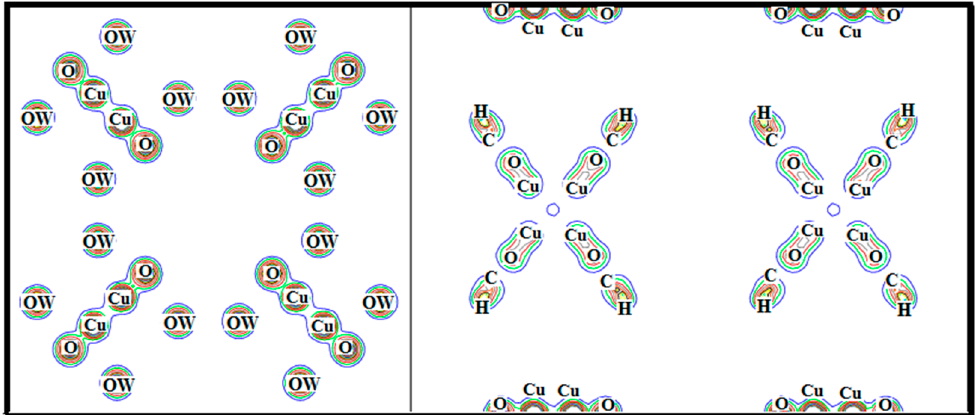
Figure 5. Electron charge densities of the HKUST-1 in (100) and in (110) crystallographic directions.